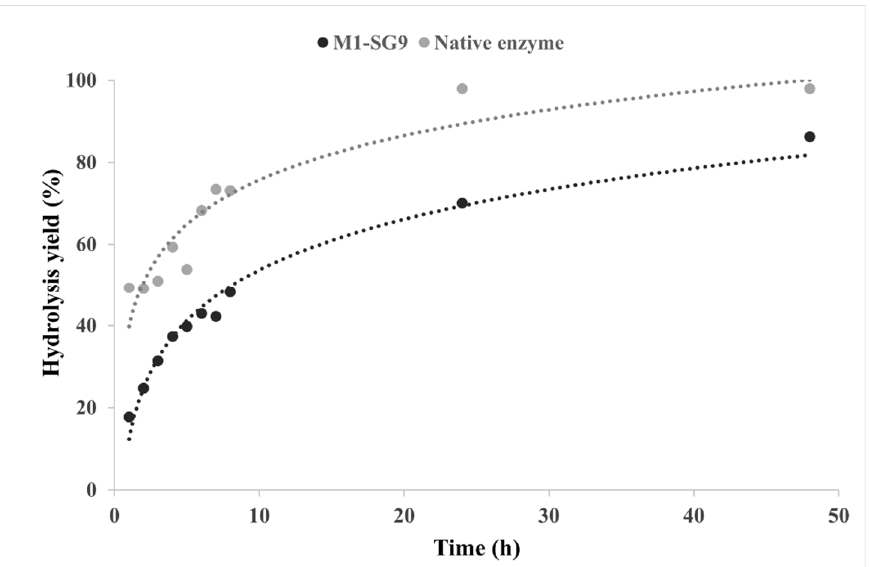
Figure 9. Time course of the enzymatic hydrolysis reaction of Avicel PH-101 cellulose that was catalyzed by native (grey) and M1-SG9 magnetic sol–gel-immobilized cellulase (black), which was obtained by using the silane network VTMOS:PhTMOS:TMOS (0.4:1.6:1) and magnetic particles MP1 (dotted lines represent fitted curves).